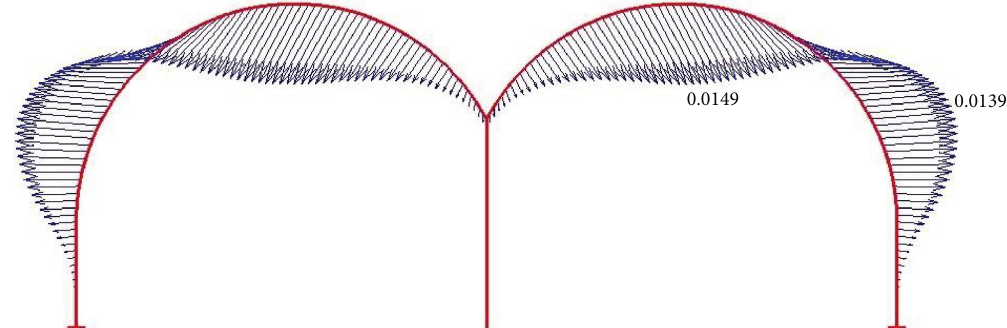
Figure 10: The deformation vector graph of the double-arched tunnel by the FEM